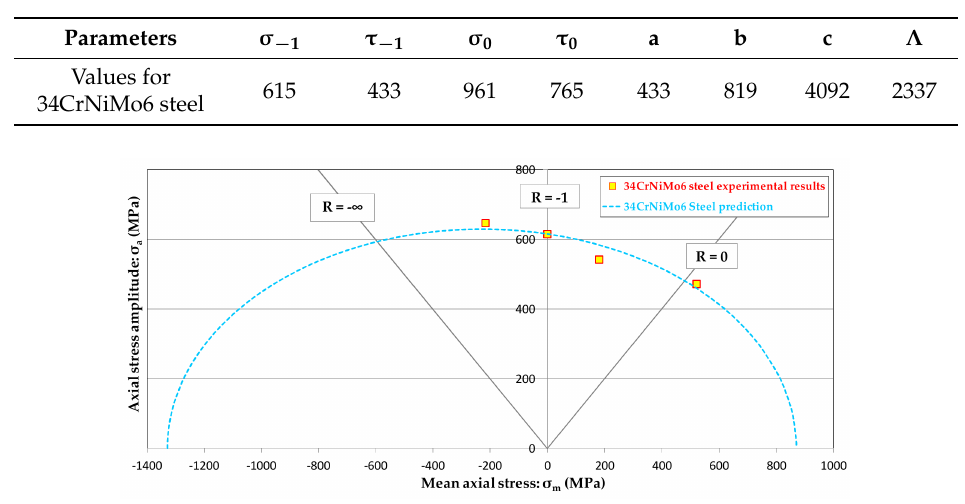
Table 6. Parameters of the proposed method applied to 34CrNiMo6 steel.